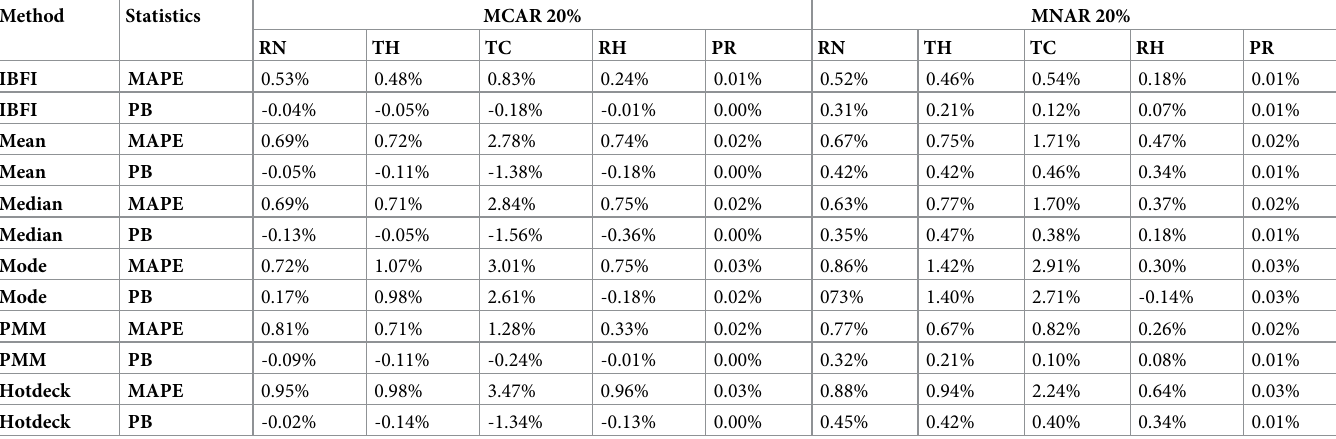
Table 2. MAPE and PB statistics for IBFI compared with other imputation methods (mean, median, mode, PMM, and Hotdeck) for 20% missingness of type MCAR and MAR and all parameters tested (RN, TH, TC, RH, and PR).